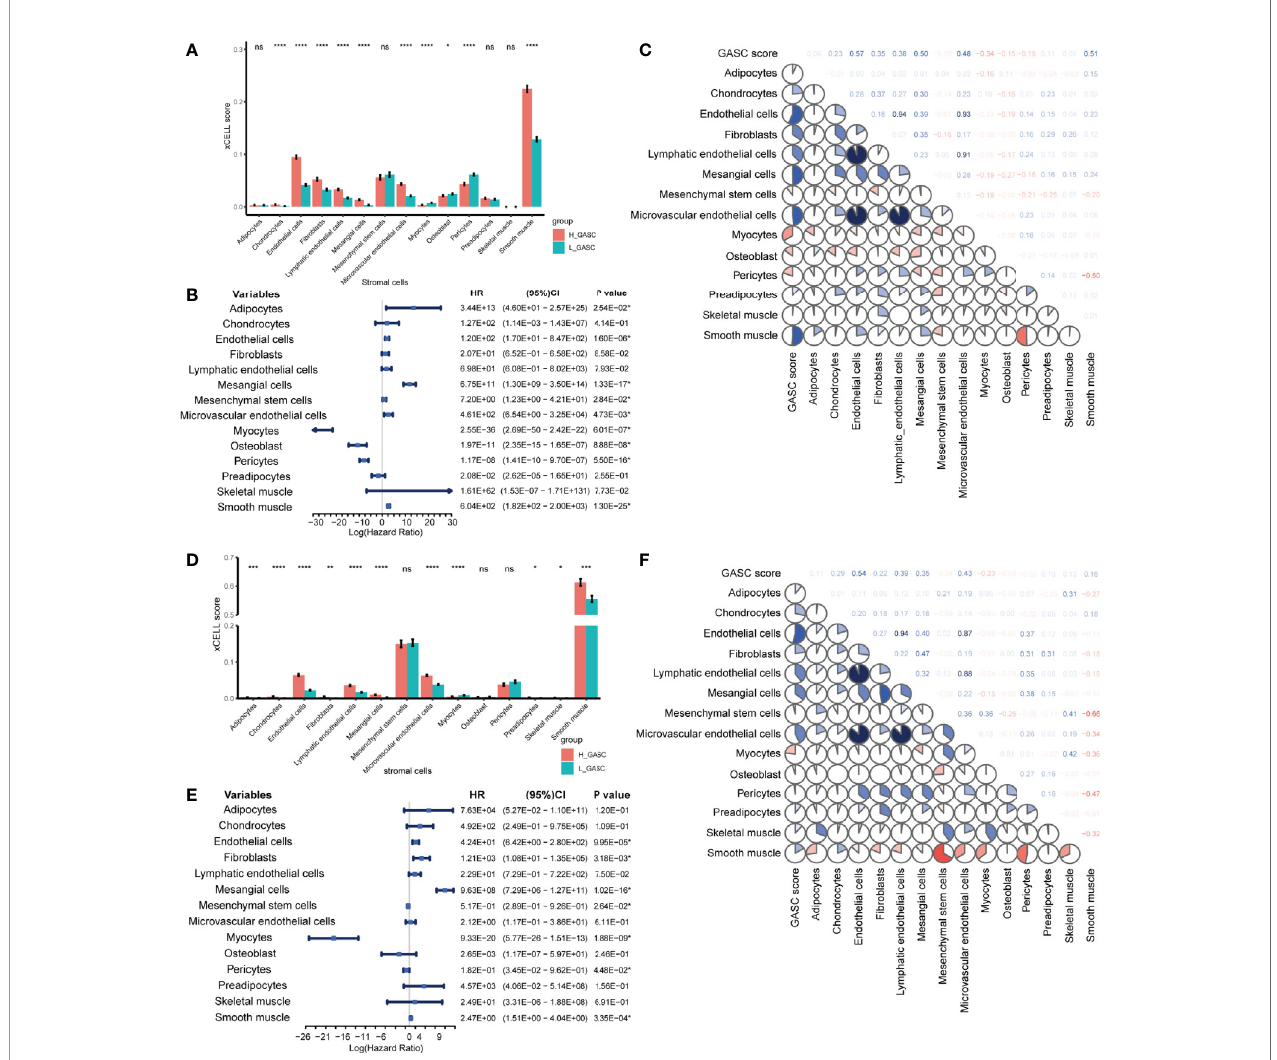
FIGURE 6 | Associations between GASCs and stromal cells in all glioma population. (A, D) Bar charts illustrating the differences of xCELL scores between high- and low-GASC groups ( A for TCGA and D for CGGA). ns: p > 0.05, * p ≤ 0.05, ** p ≤ 0.01, *** p ≤ 0.001, **** p ≤ 0.0001. (B, E) Forest plots of univariate Cox regression analysis of stromal cells ( B for TCGA and E for CGGA). (C, F) Correlograms of GASC score and stromal cells intercorrelation ( C for TCGA and F for